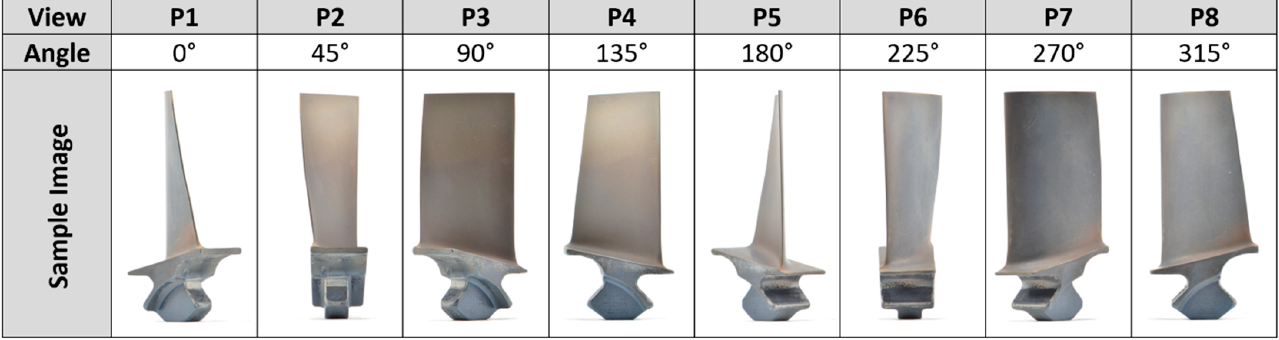
Figure 6. Different blade perspectives.